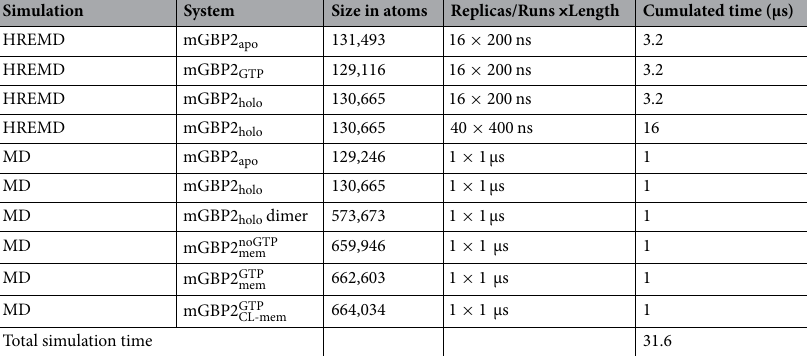
Table 2. Summary of simulations performed in this